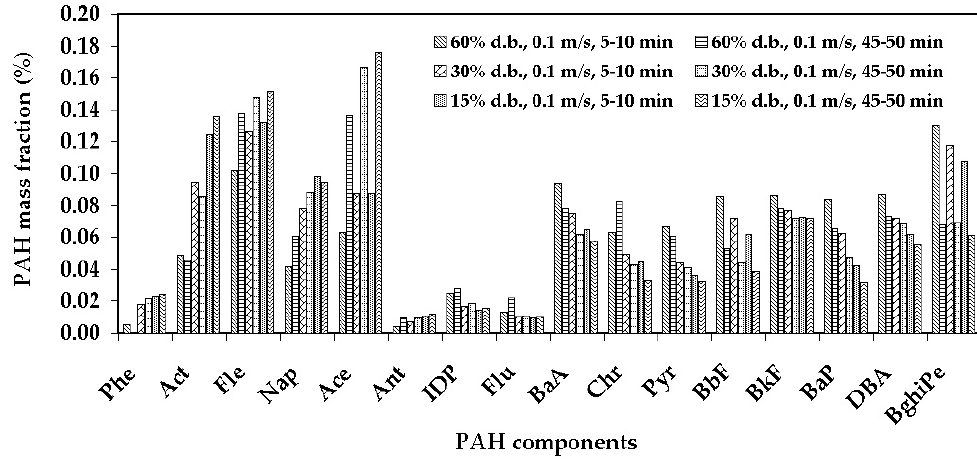
Figure 9. Mass faction of each PAH component in smoke particle samples from the palm oil sewage sludge bio-char combustion for different moisture contents and combustion periods (Phe = Phenanthrene, Act = Acenaphthylene, Fle = Fluorene, Nap = Naphthalene, Ace = Acenaphthene, Ant = Anthracene, IDP = Indeno[1,2,3-cd]pyrene, Flu = Fluoranthene, BaA = Benz[a]anthracene, Chr = Chrysene, Pyr = Pyrene, BbF = Benzo[b]fluoranthene, BkF = Benzo[k]fluoranthene, BaP = Benzo[a]pyrene, DBA = Dibenz[a,h]anthracene, and BghiPe = Benzo[g,h,i]perylene).